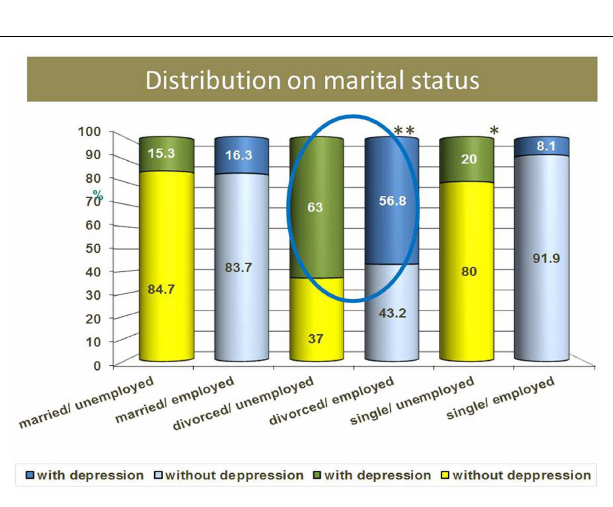
FIGURE 5 | Depression rate and marital status